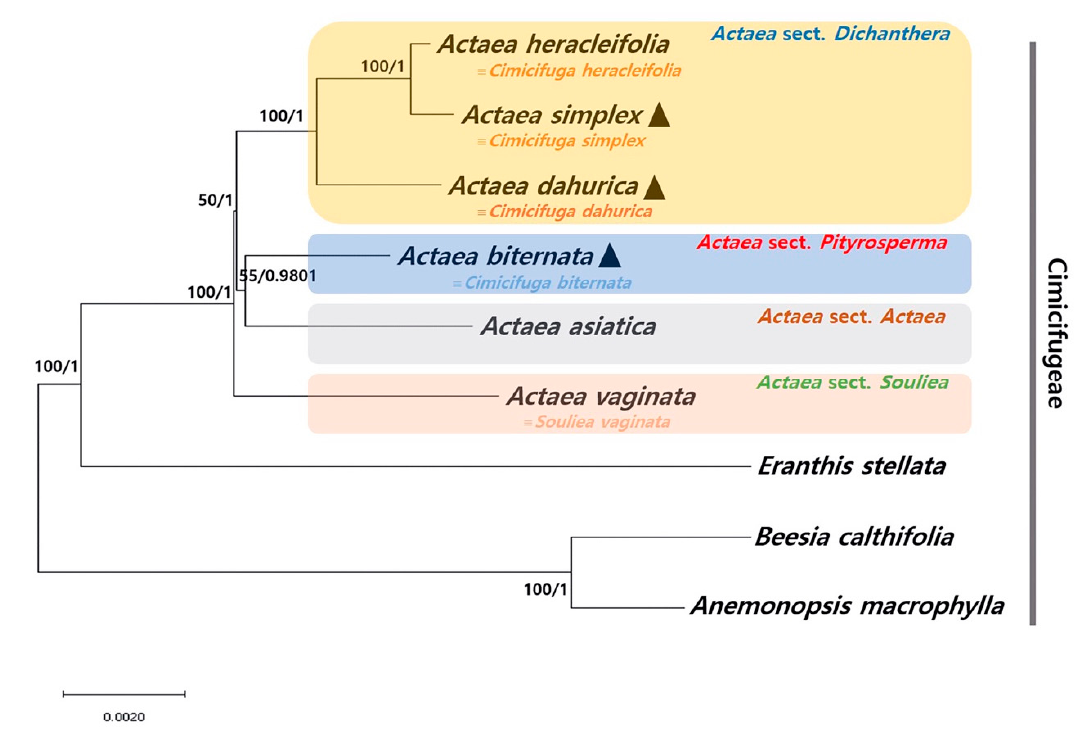
Figure 4. Phylogenetic analysis of nine species within the tribe Cimicifugeae. The phylogenetic tree was constructed with the maximum likelihood (ML) method and Bayesian Inference (BI) using 65 conserved protein-coding sequences from six Actaea species and one Eranthis species. Beesia calthifolia and Anemonopsis macrophylla were used as outgroups. ML topology is shown with bootstrap (BS) values (%), and BI posterior probability (PP) values at each node. Black triangles indicate the cp genomes of three Actaea species investigated in this study.